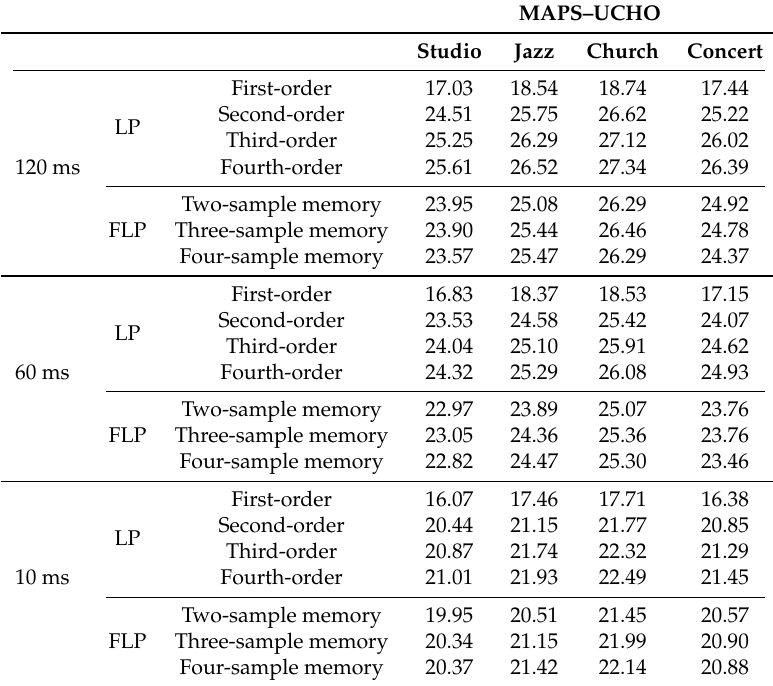
Figure 1. The prediction error results for the random chords (MAPS–RAND) for second-order, third-order and fourth-order LP and the FLP with the two-sample, three-sample, and four-sample memory: ( a ) studio recording; ( b ) jazz club recording; ( c ) church recording; and ( d ) concert hall recording. Table 2. Prediction gain (dB) for the usual Western music three-notes chords (MAPS–UCHO